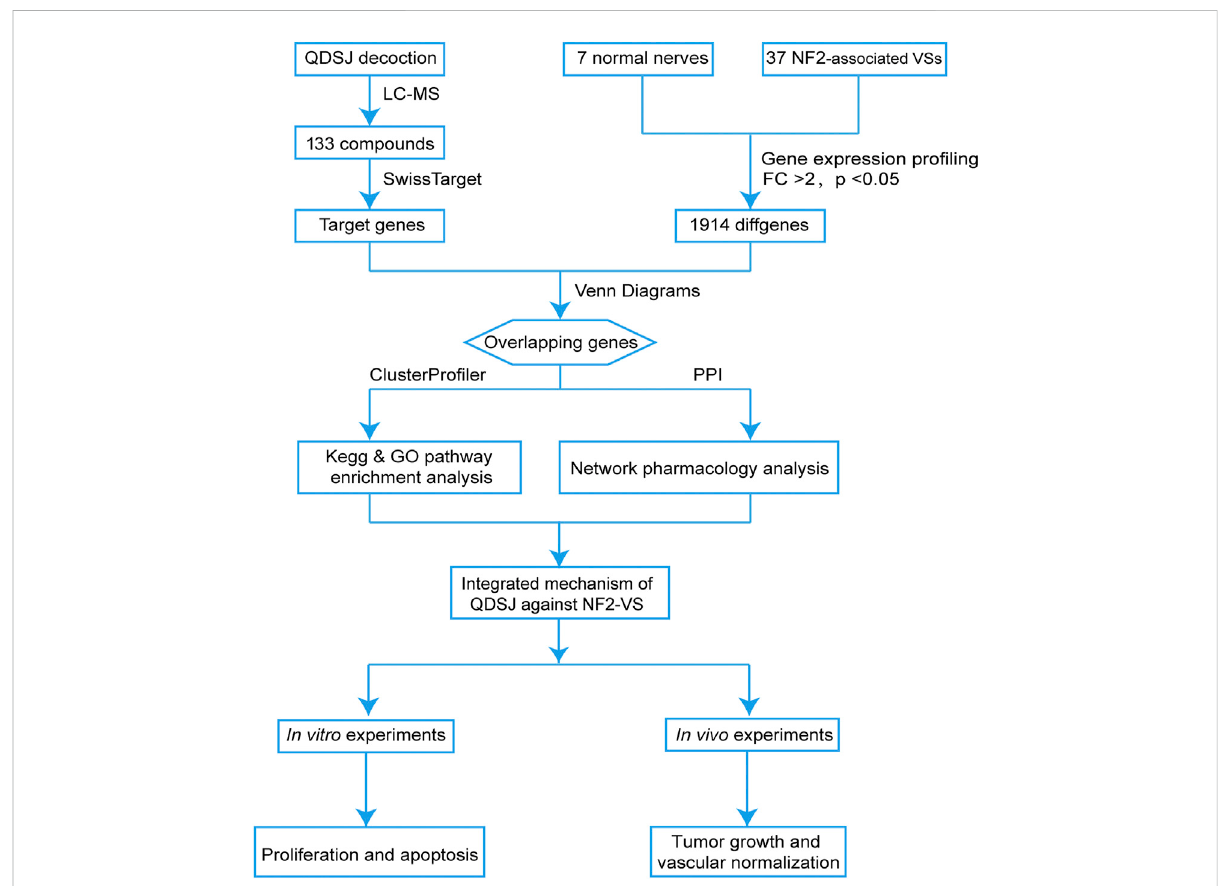
FIGURE 1 Integrated fl owchart for elucidating the mechanism of QDSJ decoction in the treatment of NF2-associated VS. First, a global view of the potential compound-target-pathway network based on UHPLC-MS results for QDSJ decoction and gene expression pro fi ling data from patients was established to predict the potential mechanisms of QDSJ decoction treating NF2-associated VS. Subsequently, in vitro and in vivo experiments using a patient-derived schwannoma cell line and a xenograft mouse model were conducted to validate the antitumor and antiangiogenic effect of QDSJ decoction treating NF2-associated